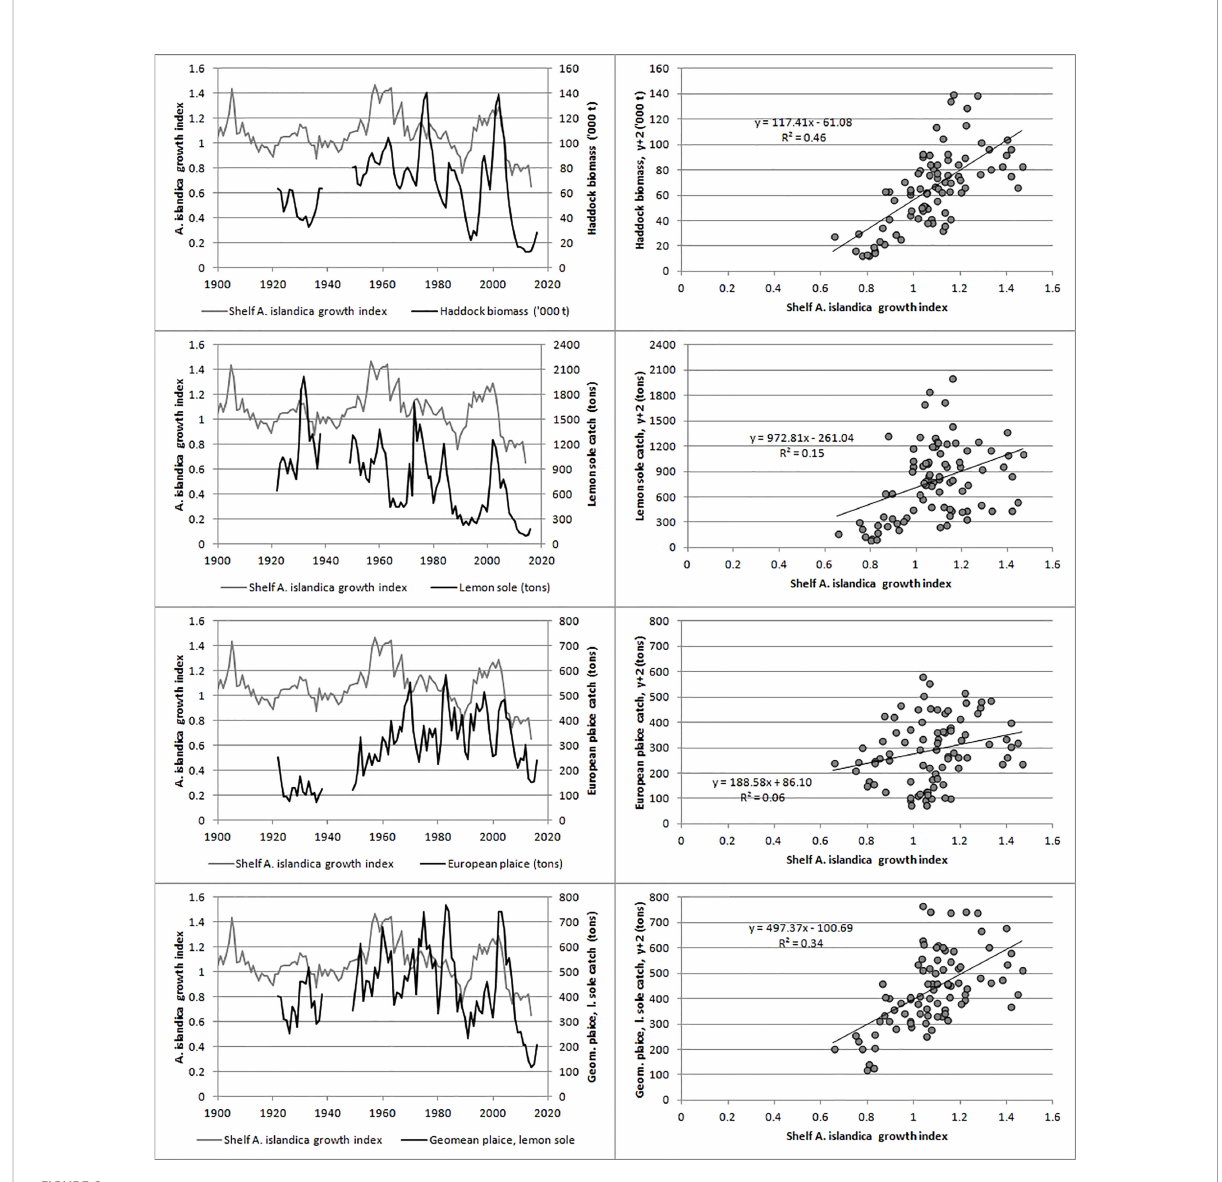
FIGURE 8 Relationship between the shelf A. islandica growth index and measures of bottom feeding fi sh on Faroe Plateau shown as time series and as scatterplots with a lag of two years (y+2). Top: haddock biomass, upper middle: catch of lemon sole, lower middle: catch of European plaice, bottom: geometric mean of the catches of lemon sole and